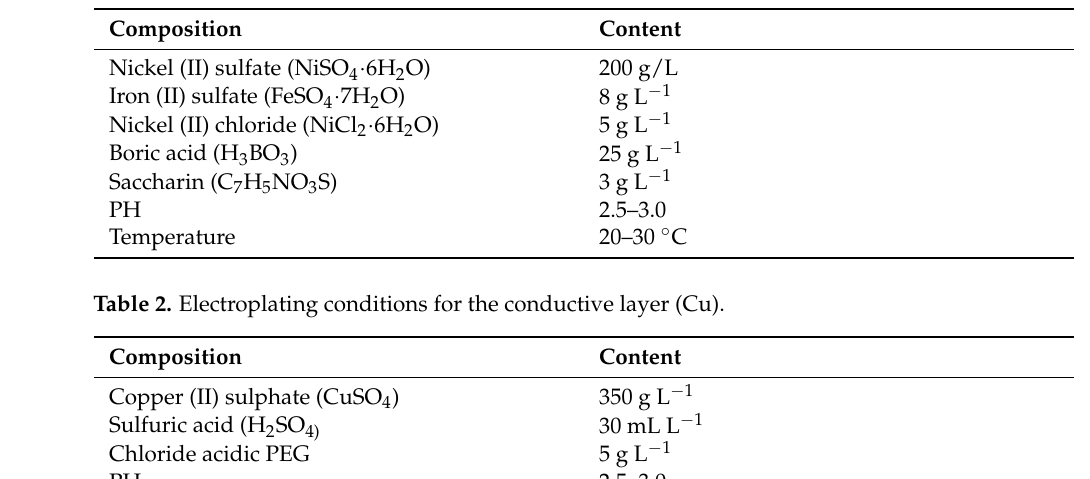
Table 1. Electroplating conditions for soft magnetic layers (Ni 82 Fe 18 ).